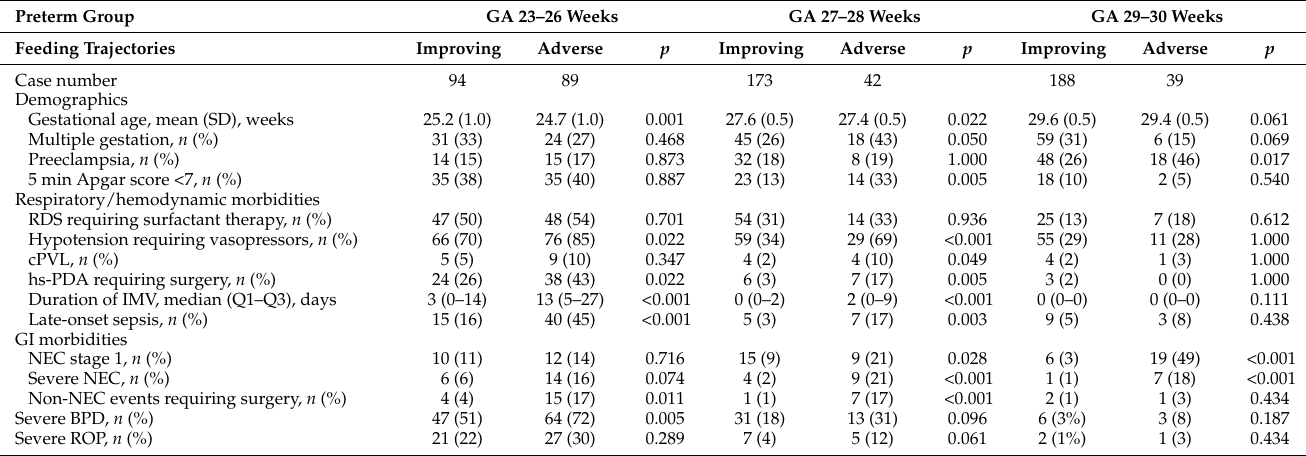
Table 1. Differences in the demographics, respiratory and hemodynamic morbidities, and GI morbidities between the improving feeding and adverse feeding patterns in each gestational age preterm group.